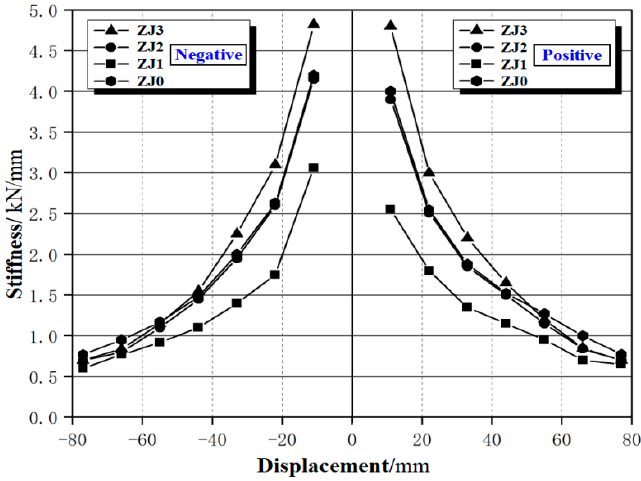
Figure 6. Stiffness degradation of the specimens. Table 3. Stiffness of the specimens in the loading process (Unit: